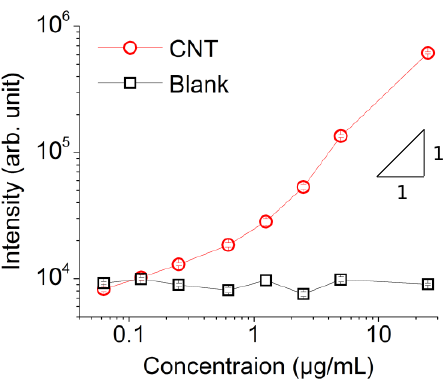
Figure 5. Luminescent intensities of the CNT dispersion samples with various concentrations measured using a V-trench biosensor. The excitation light was p-polarized. “CNT” and “Blank” were measured by applying the CNT dispersion samples and Milli-Q water into the V-trench, respectively. The error bars indicate the standard errors.